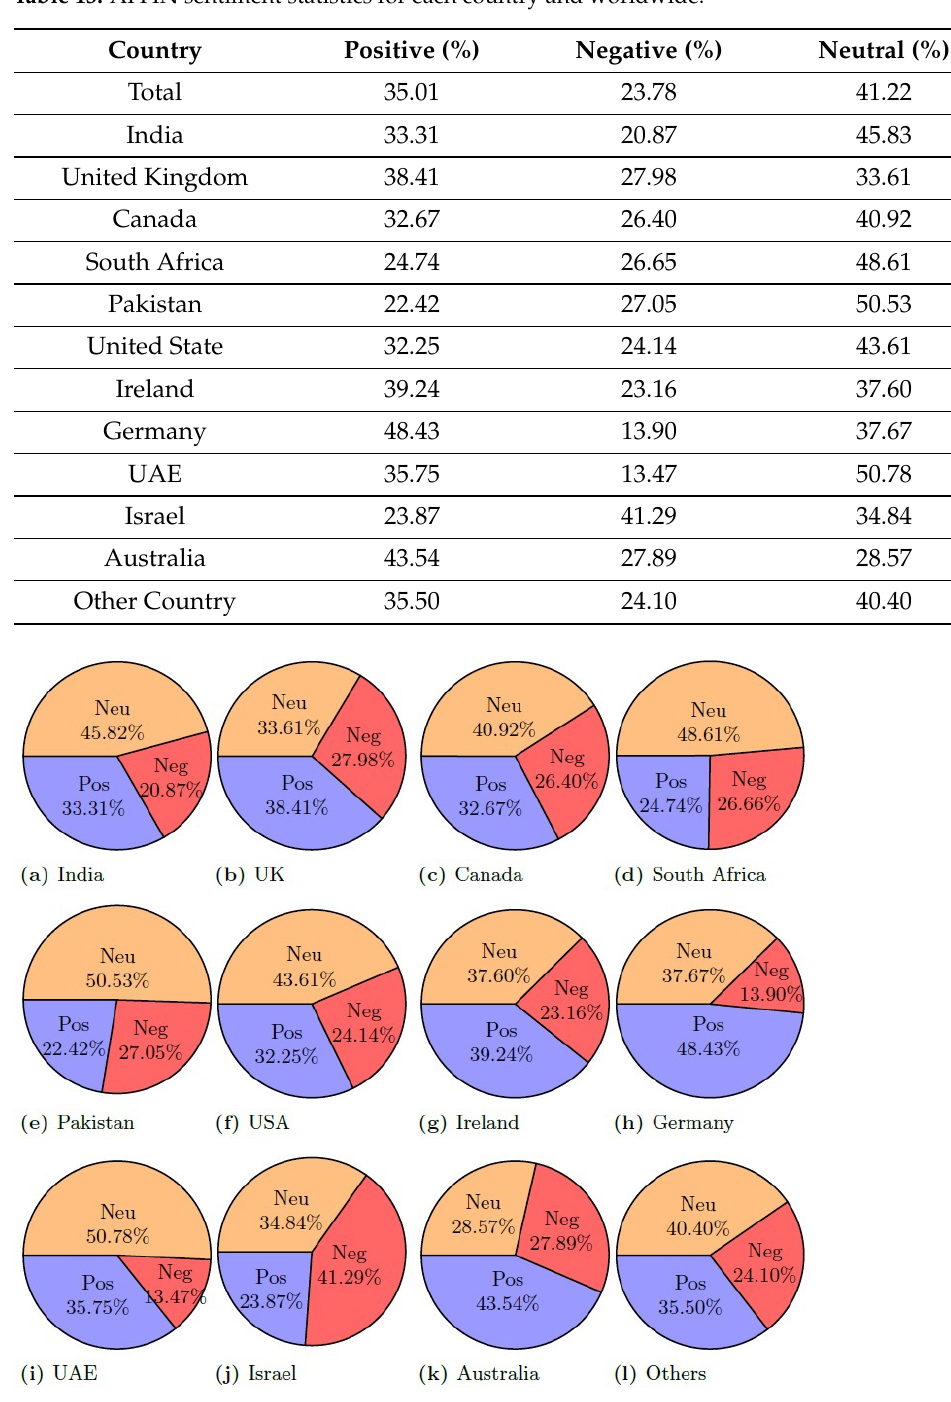
Figure 13. Percentage of the sentiment analysis for